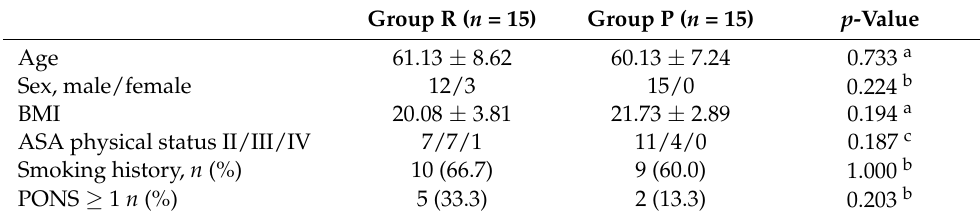
Table 1. The demographic and clinical characteristics of the patients.